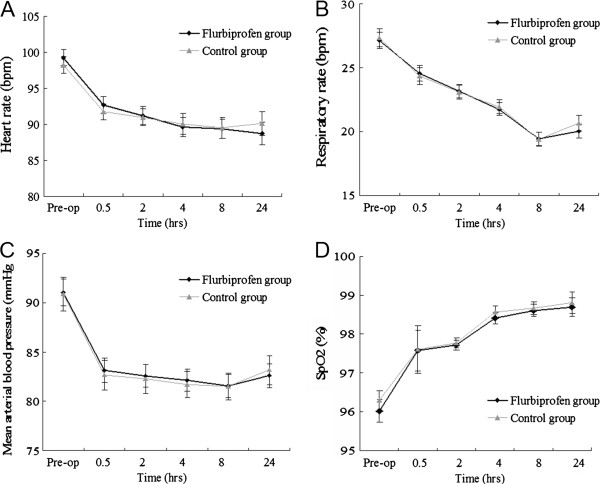
A, Comparison of heartbeat variation in theflurbiprofen and control groups;B, Comparison of respiratoryrate variation in theflurbiprofen and control groups;C, Comparison of meanarterial blood pressure variationin the flurbiprofen andcontrol groups; D, Comparisonof variation in bloodoxygen saturation in theflurbiprofen and control groups.